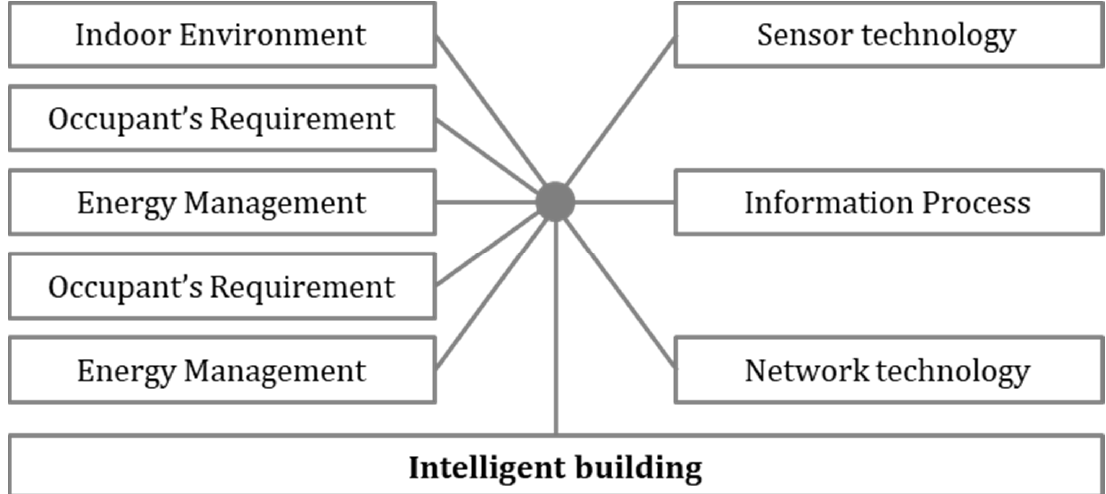
Figure 1. Integration of IoT technology into an intelligent building.